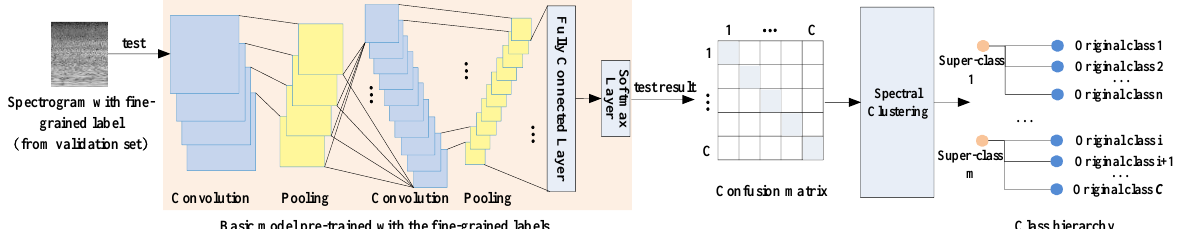
Figure 3. The pipeline of the construction of super-class labels. Each sample in the validation set is evaluated by the trained basic CNN model. The prediction results are collected to compute a confusion matrix. Then, a spectral clustering algorithm is performed upon this matrix. As a result, original acoustic scene classes are clustered into several subsets. The classes in the same subset are considered as similar scenes and the same super-class label is assigned to their corresponding samples.